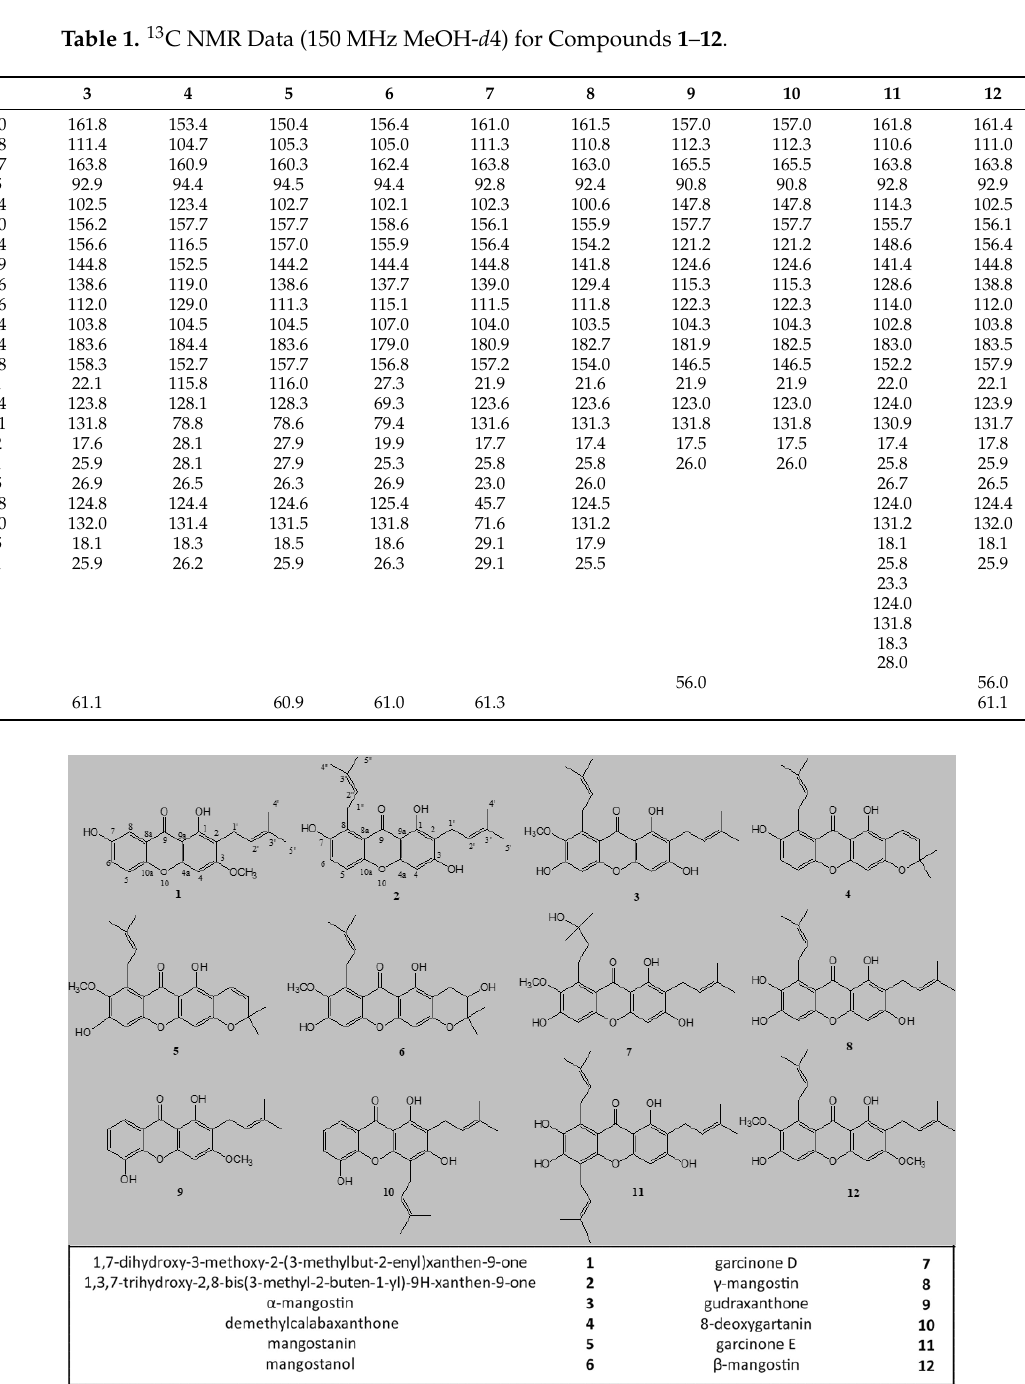
Figure 1. Chemical structures of xanthone derivatives ( 1 – 12 ) isolated from Garcinia mangostana .